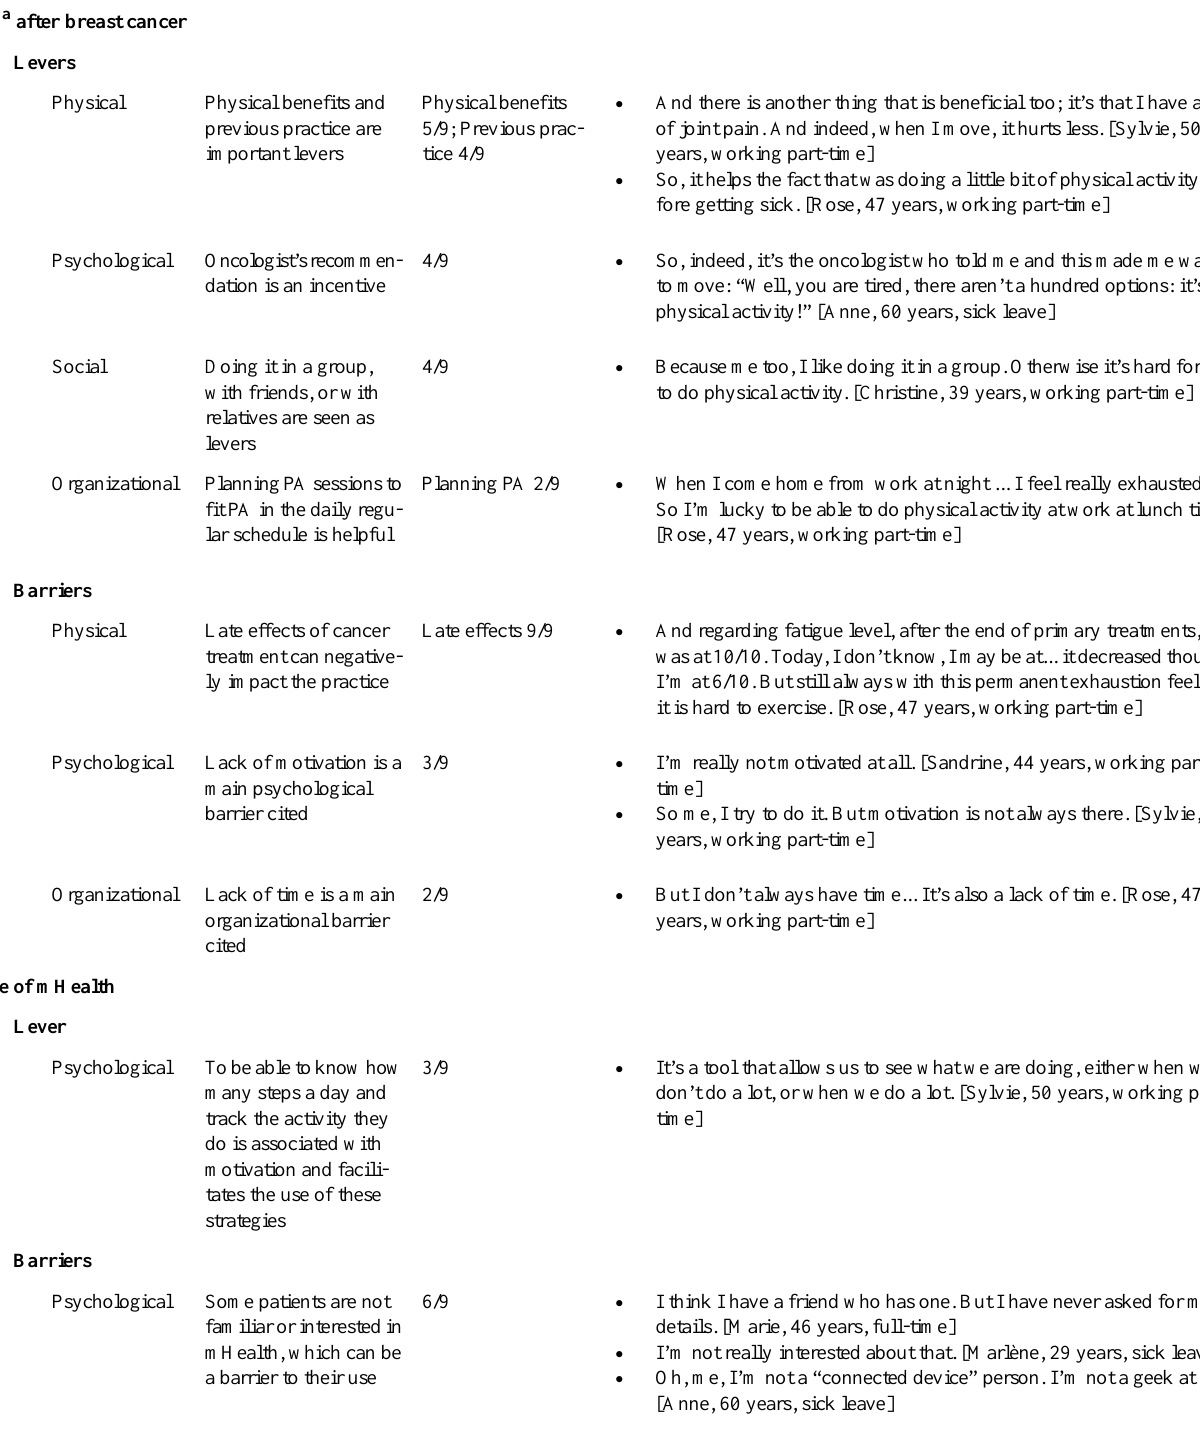
QuotesNumber of